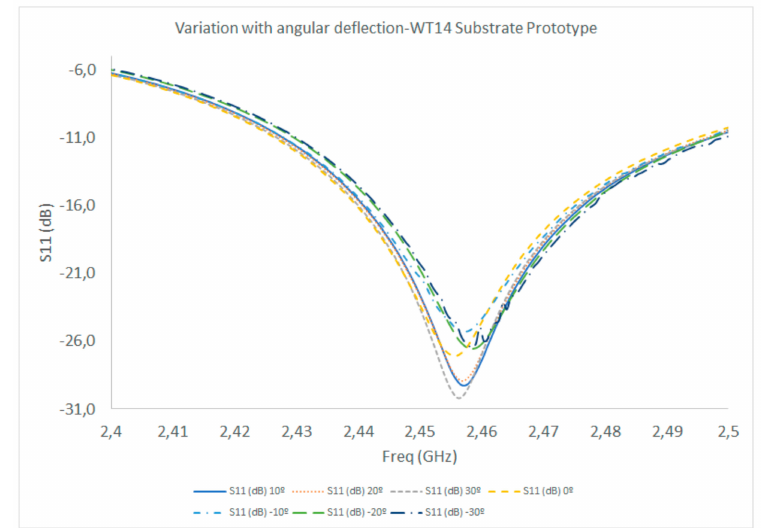
Figure 7. S11 parameter measurement results (WT14 substrate prototype), as a function of temperature variation in the prototype curing process.